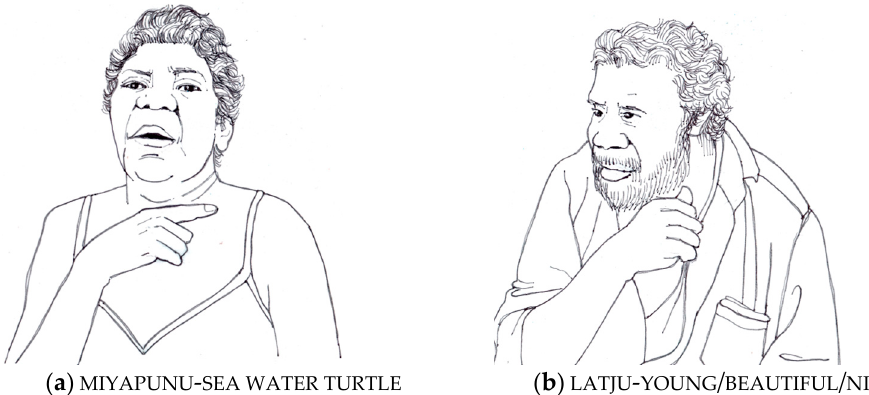
Figure 5. A Yolngu minimal pair for handshape ( a ) MIYAPUNU - SEA WATER TURTLE ( b ) LATJU - YOUNG / BEAUTIFUL / NICE (Illustrations: Jennifer Taylor).